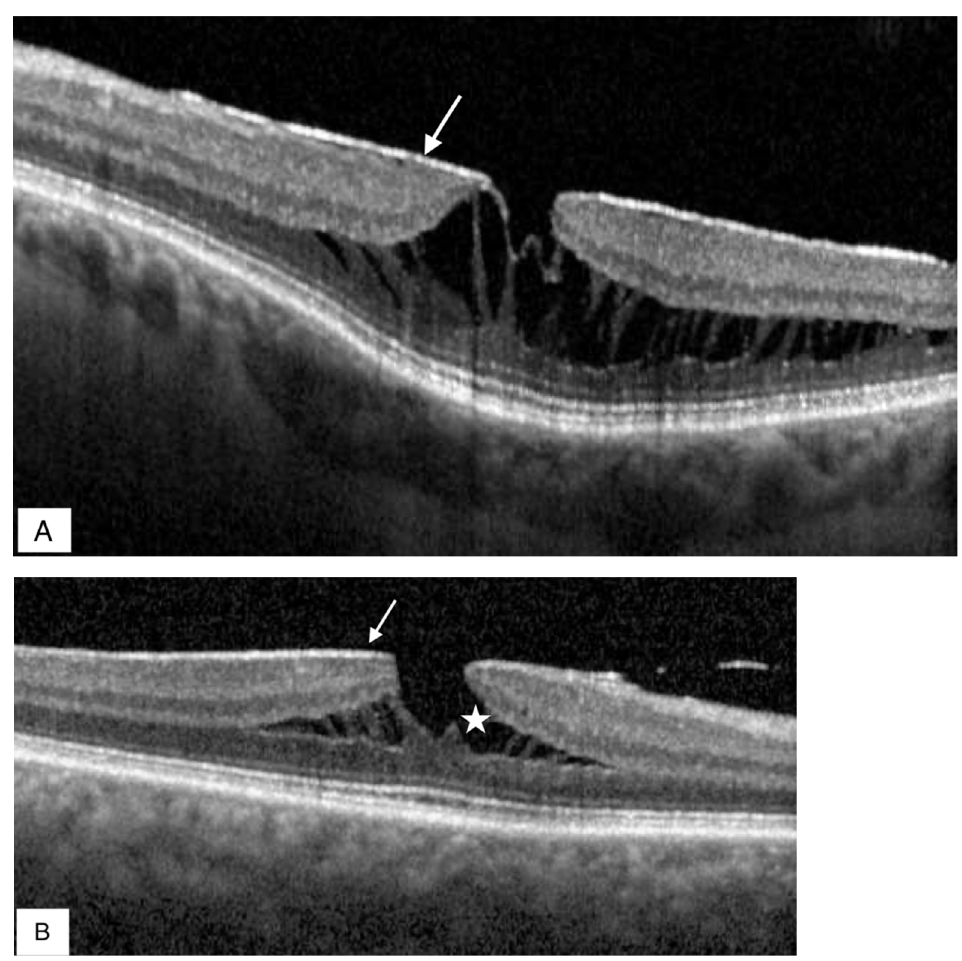
Figure 1. B scan SD-OCT of an eye with an LMH. Notice the epiretinal proliferation (arrow) that is isoreflective and conforms to the retinal surface without altering the retina shape. There is no evi- dence of traction. The foveal contour is irregular. SD-OCT: Spectral Domain optical coherence to- mography; LMH: Lamellar Macular Hole.